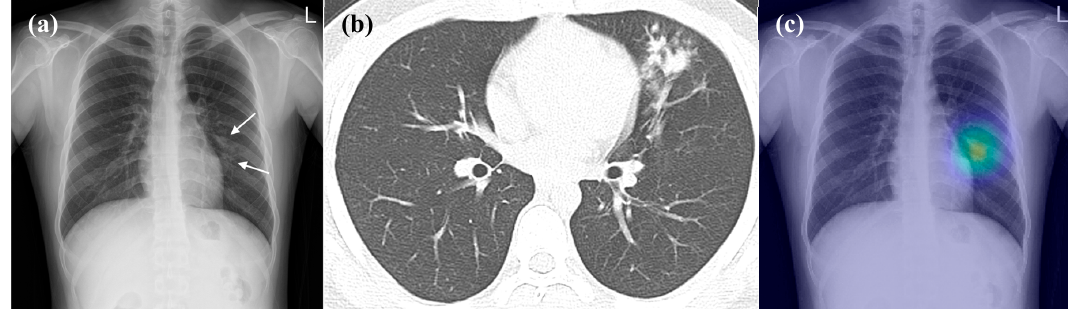
Figure 4. Representative case of the observer performance test. ( a ) The CR demonstrates patchy opacity in the left middle lung field (arrow), which was initially detected by only one of three observers. ( b ) The CT taken on the same day shows branching opacities and centrilobular nodules at the left upper lobe. ( c ) The DL algorithm correctly detected the lesion (probability score, 0.577). After assistance from the DL algorithm, all observers detected the lesion.